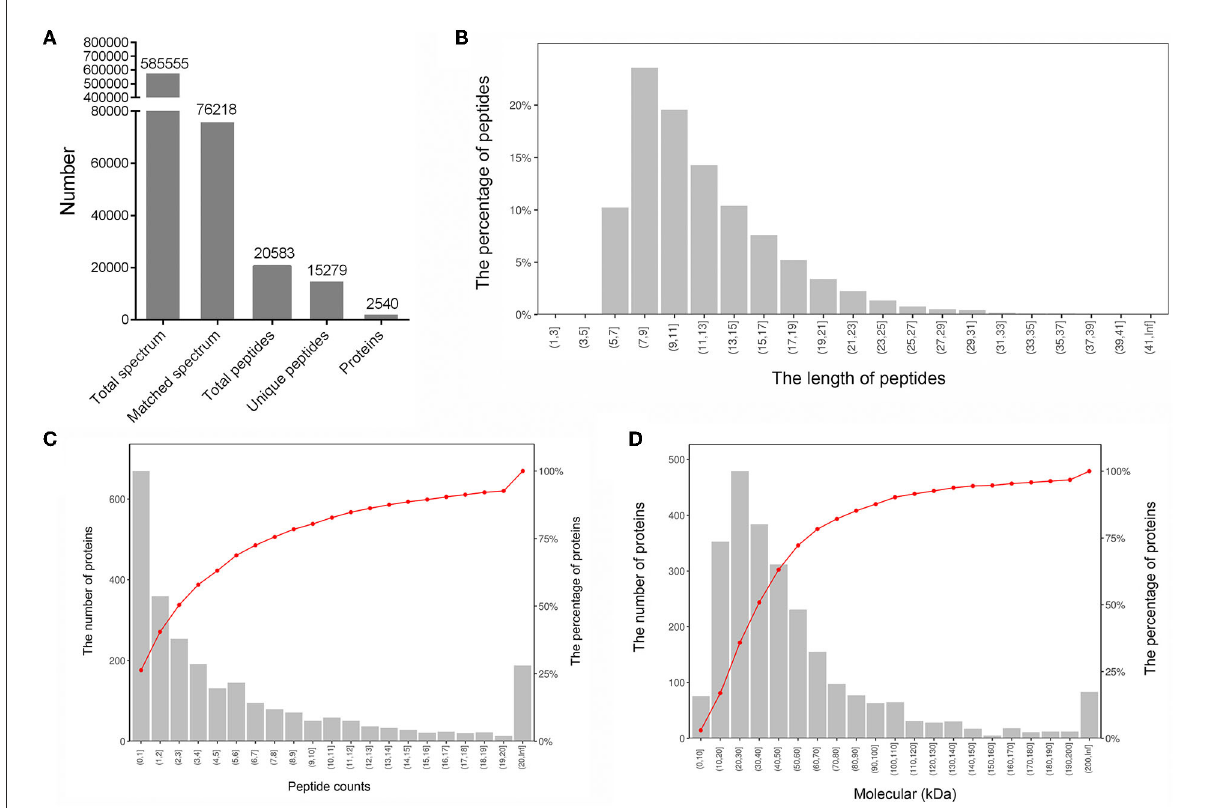
FIGURE2 Characterization of proteins from six longissimus dorsi muscle samples. (A) Overview information of identified proteins in this study. (B) Distribution of the lengths of the identified peptides. (C) Distribution of the numbers of identified proteins containing different numbers of peptides. (D) Distribution of the molecular weights of the identified